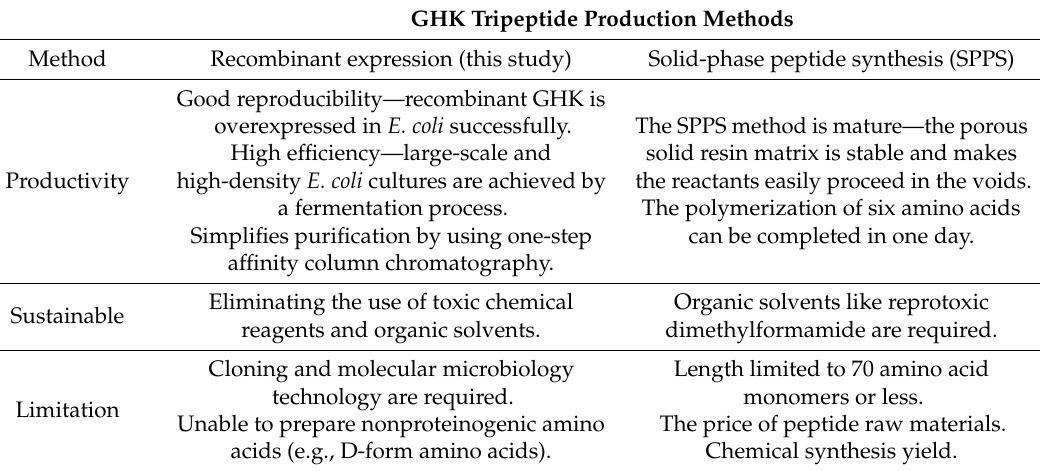
Table A1. Comparison of the pros and cons of the two major methods for GHK tripeptide